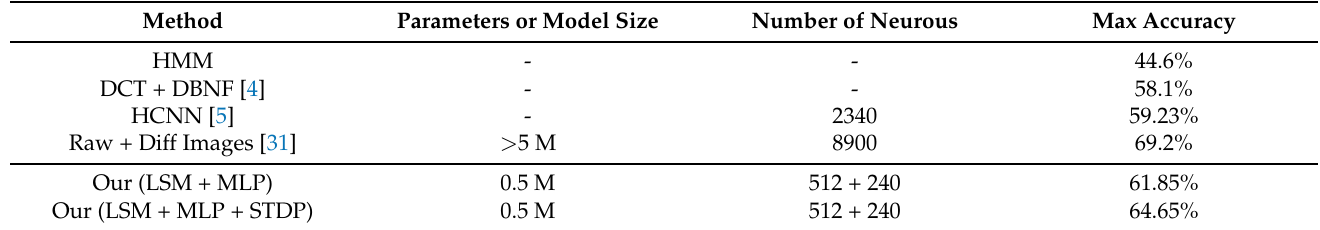
Table 2. Results on the AVLetters Dataset.